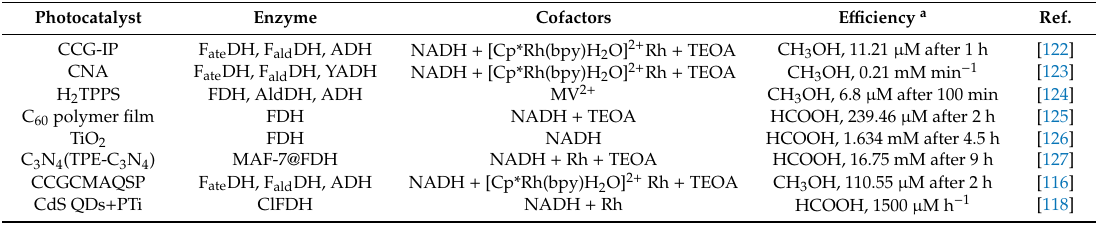
Table 2. Performance comparison of di ff erent coupled photocatalytic / enzymatic CO 2 reduction